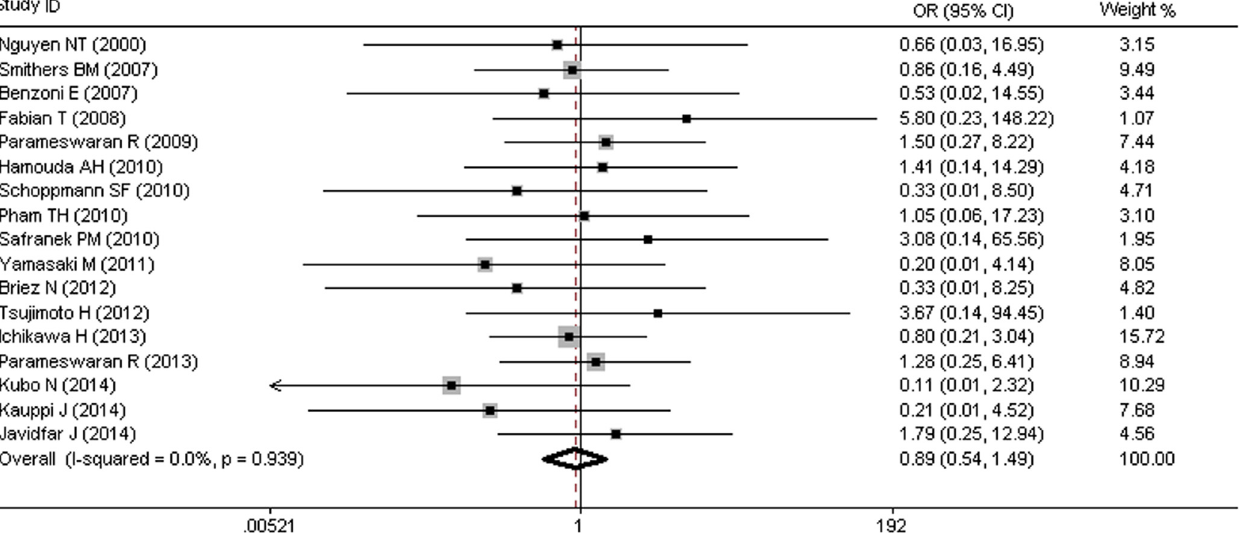
Fig 7. MIO and Risk of Gastric Tip Necrosis